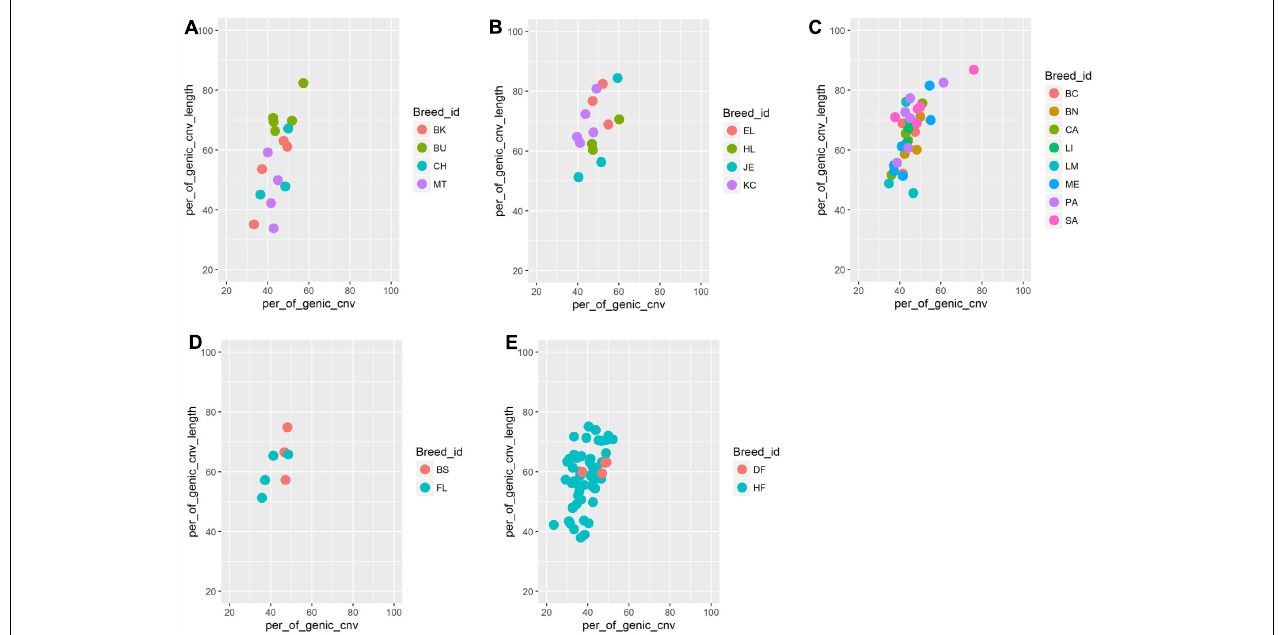
FIGURE 5 | Percentage of genic CNV counts (on X axis) and cumulative genic CNV length (on Y -axis) per individual split based on breed and its geographical region. (A) Balkan and Italian cattle breeds (BAI), (B) British and Irish cattle breeds (BAI), (C) Iberian cattle breeds (IBR), (D) Alpine cattle breeds (ALP), and (E) Dutch (NLD) cattle